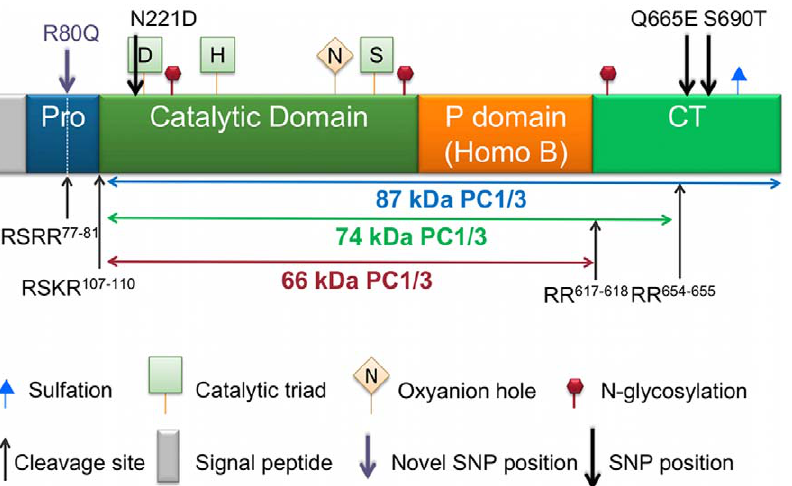
Figure 1. Domain structure and SNP locations within preproPC1/3. The upward arrows indicate the cleavage sites required for PC1/3 maturation. The downward arrows indicate locations of previously described (black) and novel (purple) SNP. The dashed line between the pro and catalytic domains represents a primary cleavage site (occurring in the ER) that is required for activation. The dashed line in the middle of the prodomain indicates the secondary cleavage site (likely cleaved in the trans-Golgi network). The P or Homo B domain following the catalytic domain is important for the stabilization of the catalytic domain, as well as determining various enzymatic properties. The C-terminal domain plays a role in efficient routing of PC1/3 to the secretory granules, and contributes to substrate specificity as well as to specific activity and